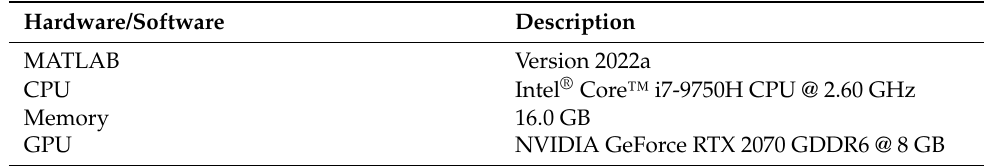
Table 4. Hardware and software description.